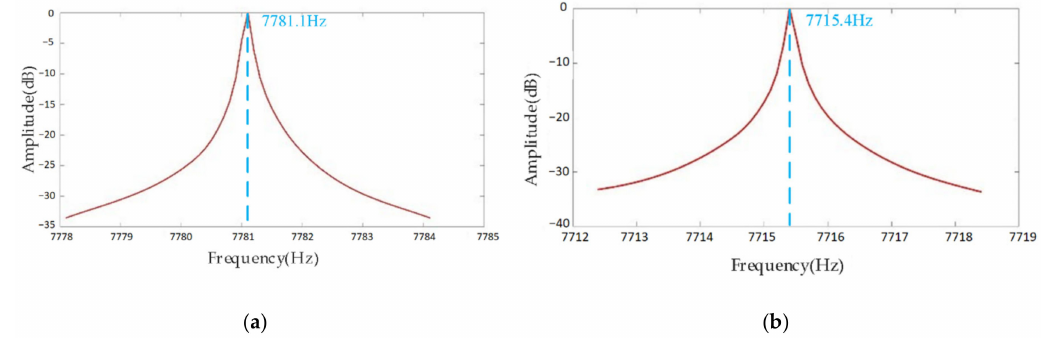
Figure 23. Resonance frequencies in ( a ) drive mode and ( b ) sense